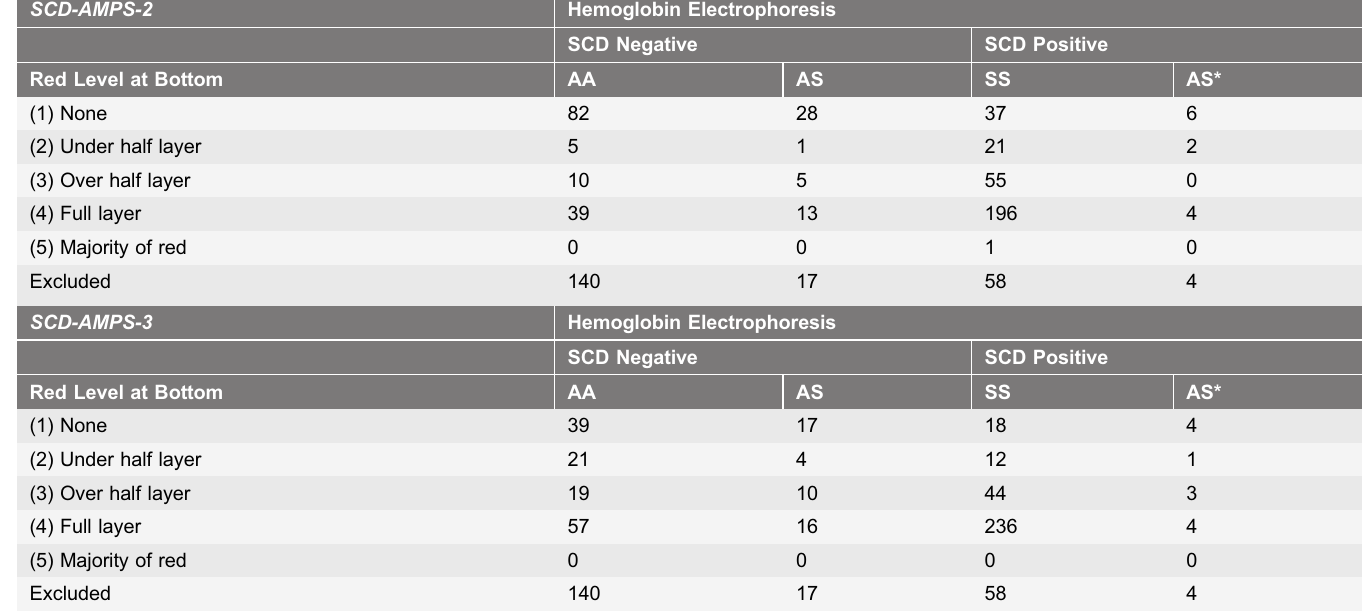
Table 3. Tabulation of Results of SCD-AMPS Tests Compared to Reference Test Results by Hemoglobin Electrophoresis. SCD-AMPS-2 Hemoglobin Electrophoresis SCD Negative SCD Positive Red Level at Bottom